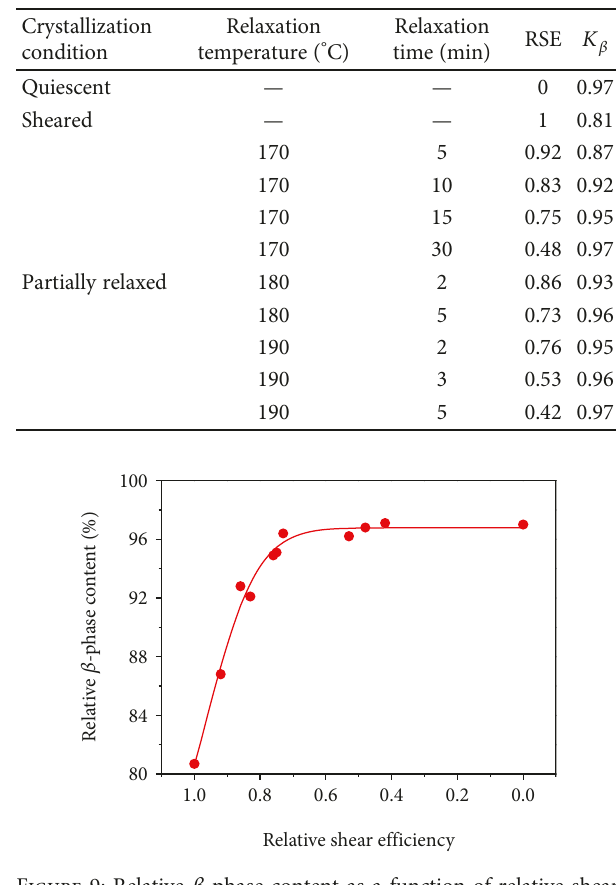
Figure 6: WAXD patterns of β -nucleated iPP crystallized at 135 ° C under (a) quiescent condition and (b) shear condition ( shearrate = 40s − 1 , shear time = 10s , and T = 170 ° C ). S Table 1: Relative β -phase content and relative shear e ffi ciency of β - nucleated iPP under di ff erent relaxed conditions.